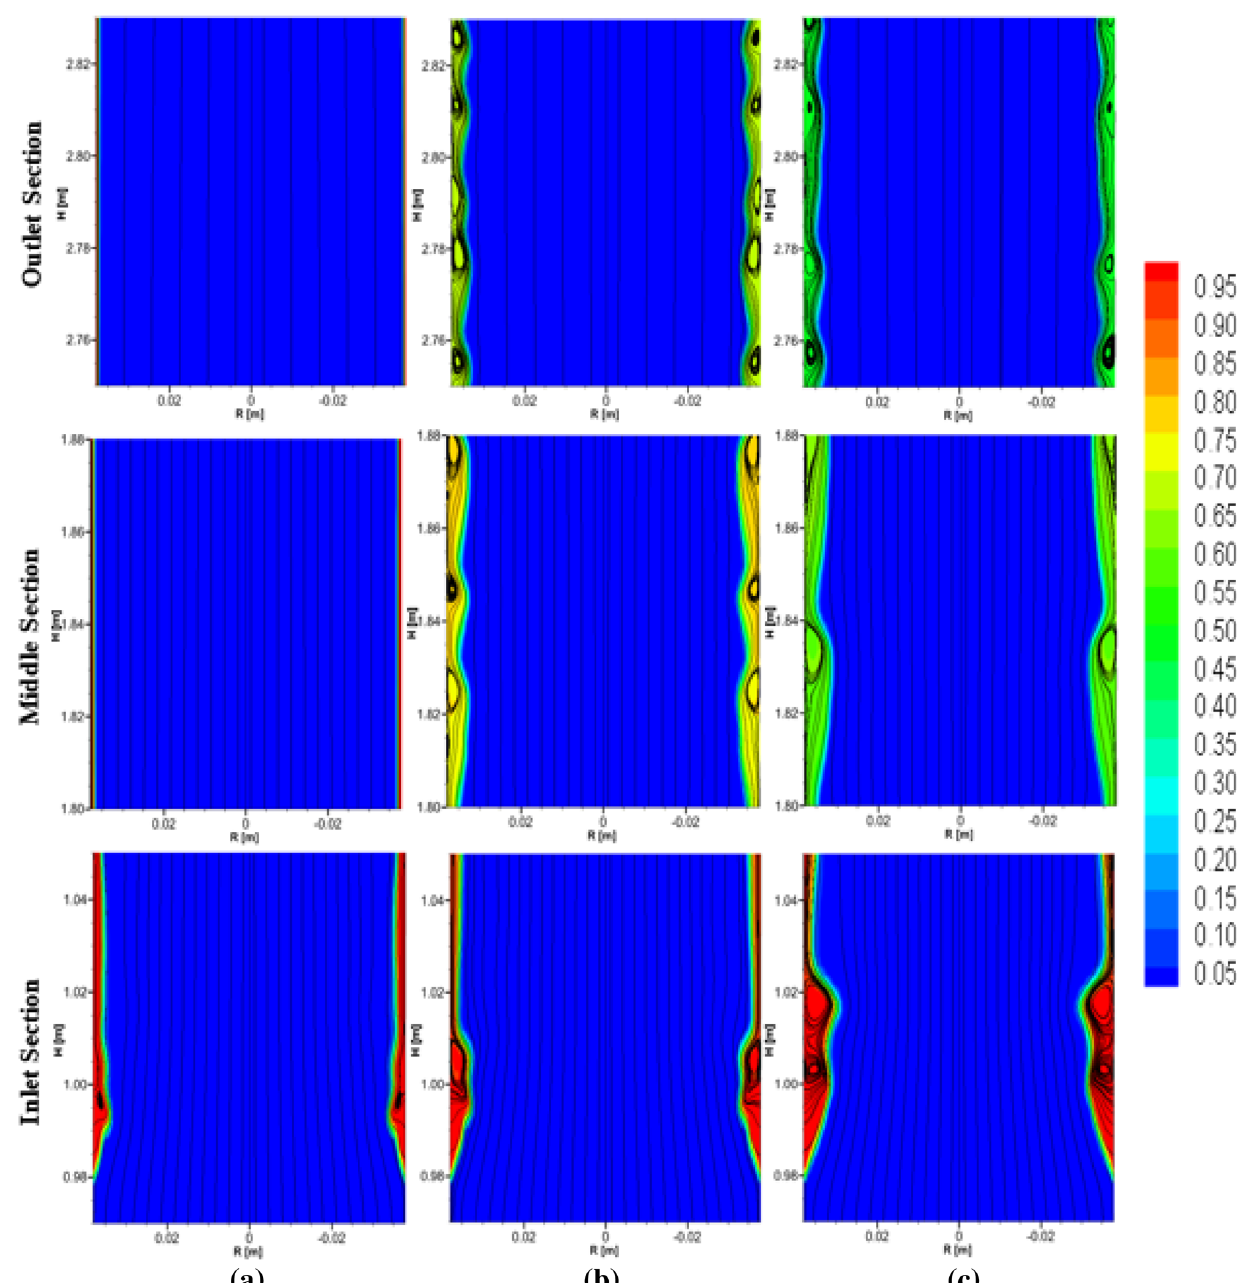
Fig. 3 Typical flow field phase distribution and stream traces: a higher U U SG = 21.17 m/s), c lowest (